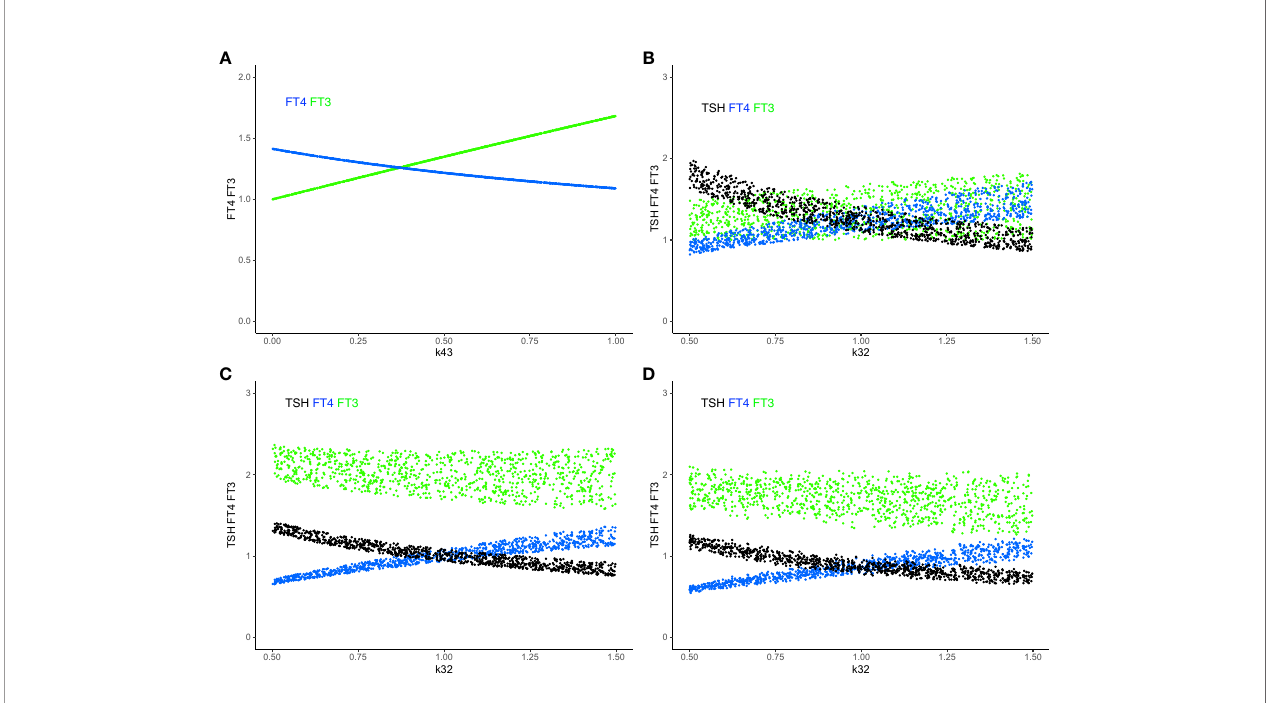
FIGURE 5 | Combining mechanisms of FT3 homeostasis and FT3 adaptation. (A) In system (sys. 9), with k32 = 1, k423 = 0.5, k42 = 0 and other parameters =1, increasing k43 (the FT3 production rate constant of peripheral organs) increases the level of FT3 (green curve), while the level of FT4 decreases (blue curve). FT3 and FT4 move in opposite directions. This mechanism disjoins the levels of FT3 and FT4. (B) The level of FT3 is protected by this mechanism in system (sys. 9) within a certain range, as both k43 = 0-1 (as in A) and k32 (FT4 production rate constant) vary simultaneously. (C) In system (sys. 10), the TSH feedforward on FT3 is switched on (k42 = 1). This mechanism increases the level of FT3 more strongly, as k32 decreases, compared to B (sys. 9, k42 = 0). (D) In system (sys. 10), decreasing the range of s1 (TRH production rate constant) (here s1 = 0.5 to 0.1, with other parameters as in (C) shifts and reduces the range of FT3 levels, compared to C. Color code of hormones: TSH black, FT4 blue, FT3